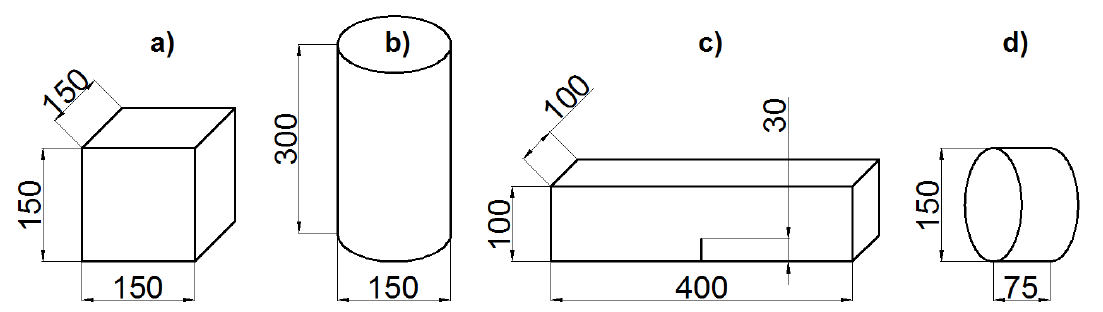
Figure 4. Geometry of the specimens used to determine: ( a ) compressive strength; ( b ) elastic modulus; ( c ) fracture energy; and ( d ) indirect tensile